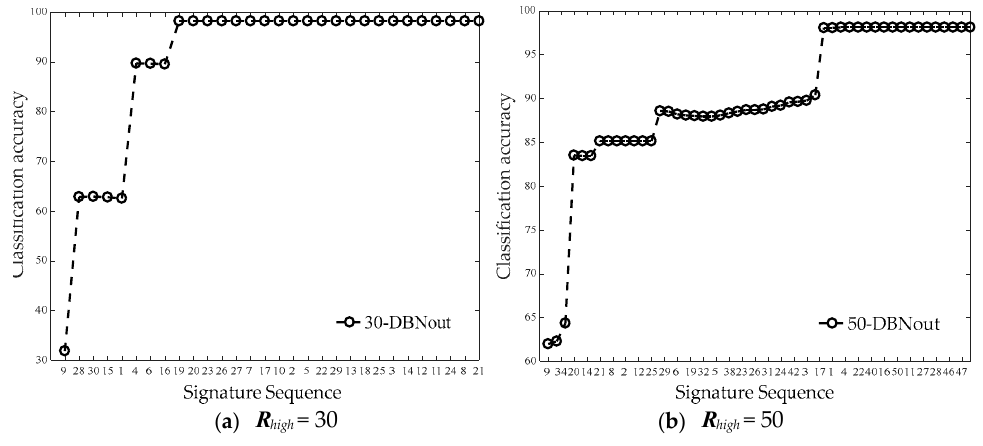
Figure 9. Optimal feature ranking when high R was 30 or 50.